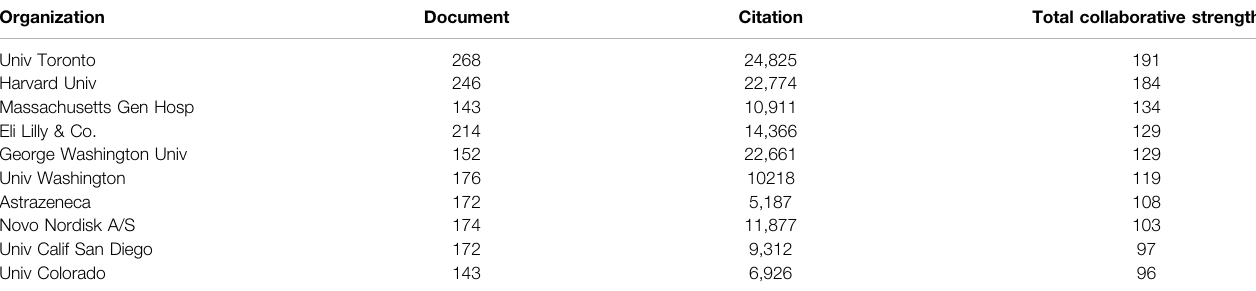
TABLE 1 | The top 10 most collaborative institution. Organization Document